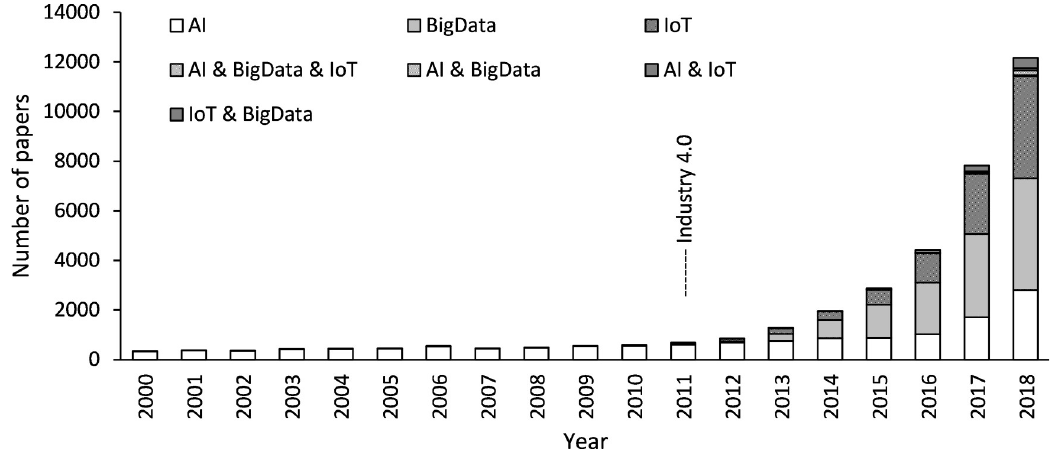
Fig 1. Number of papers on artificial intelligence, big data, and internet of